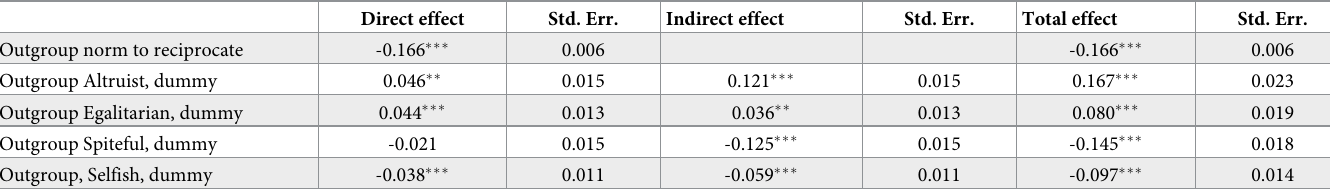
Table 7. Estimated direct, indirect, and total effects of social preferences and norms on outgroup